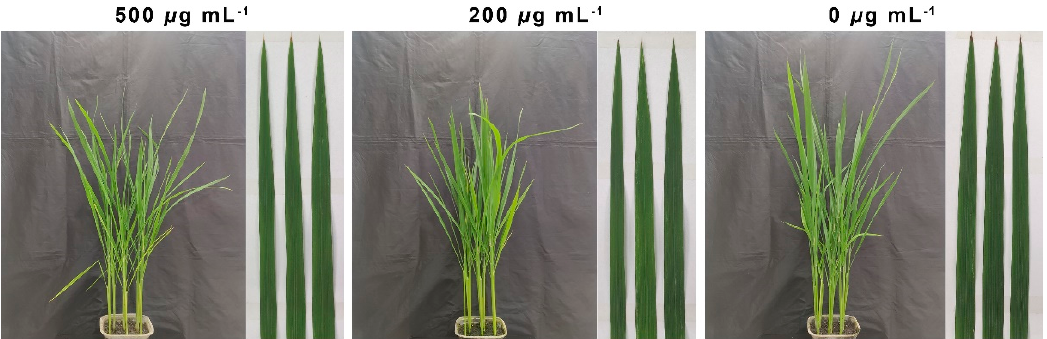
Figure 11. The phytotoxicity assessment of compound 2b on rice leaves after co-culturing it for seven days at 0, 200, and 500 µ g mL − 1